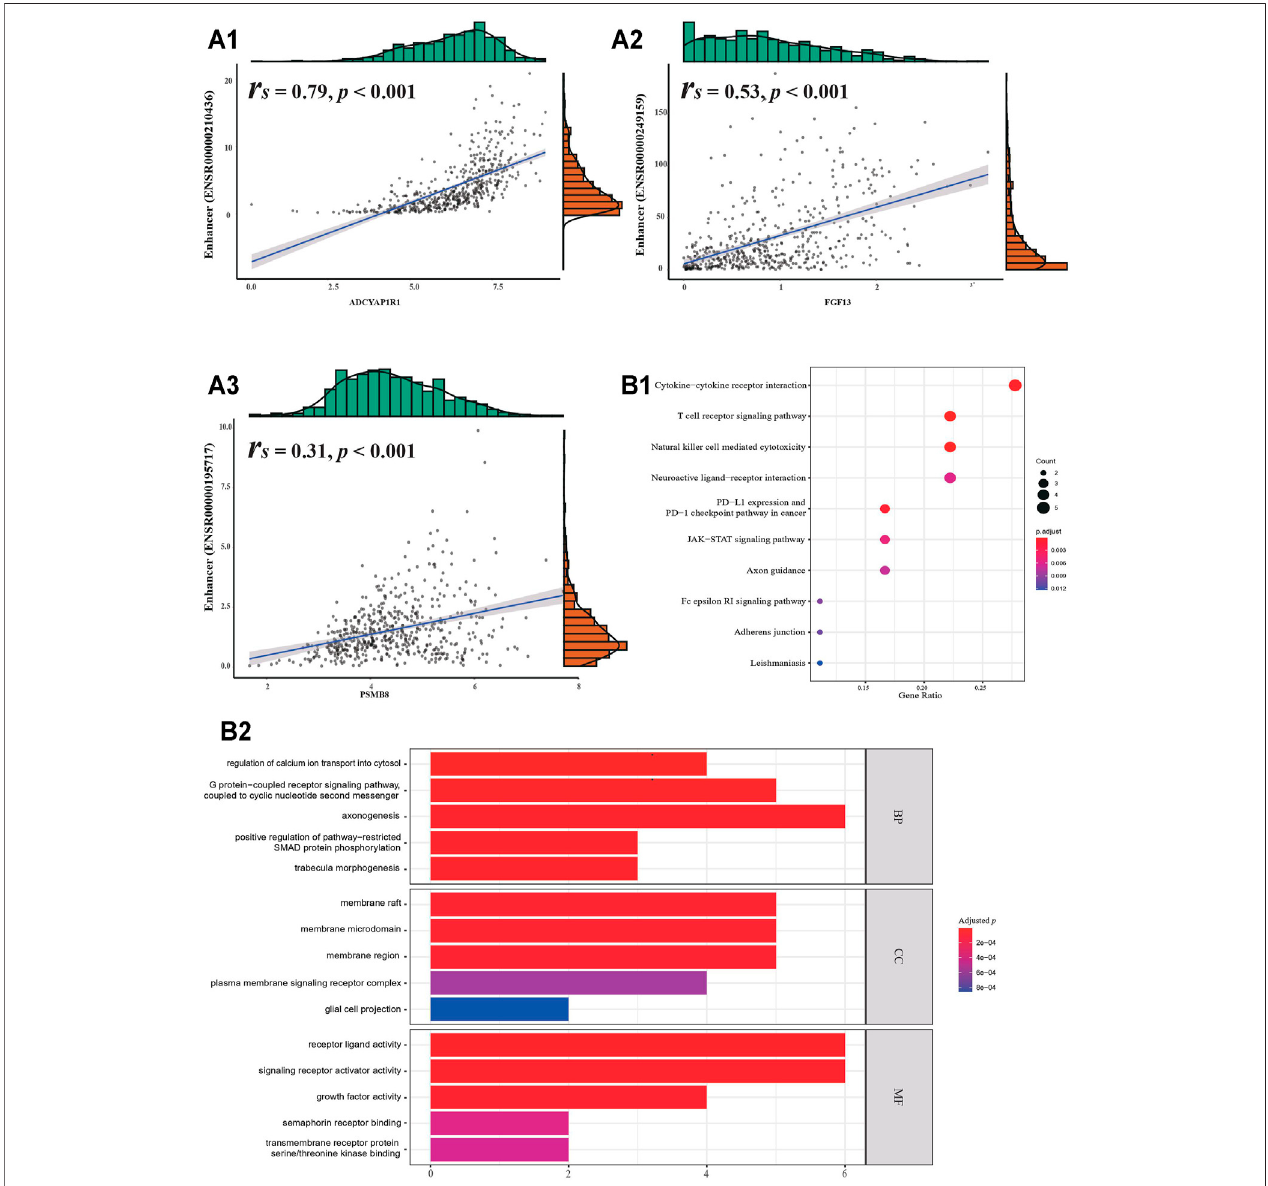
FIGURE 2 | Identi fi ed target genes. (A1) Correlation between eRNA and its target gene. (B1) KEGG enrichment analysis. (B2) GO enrichment analysis.